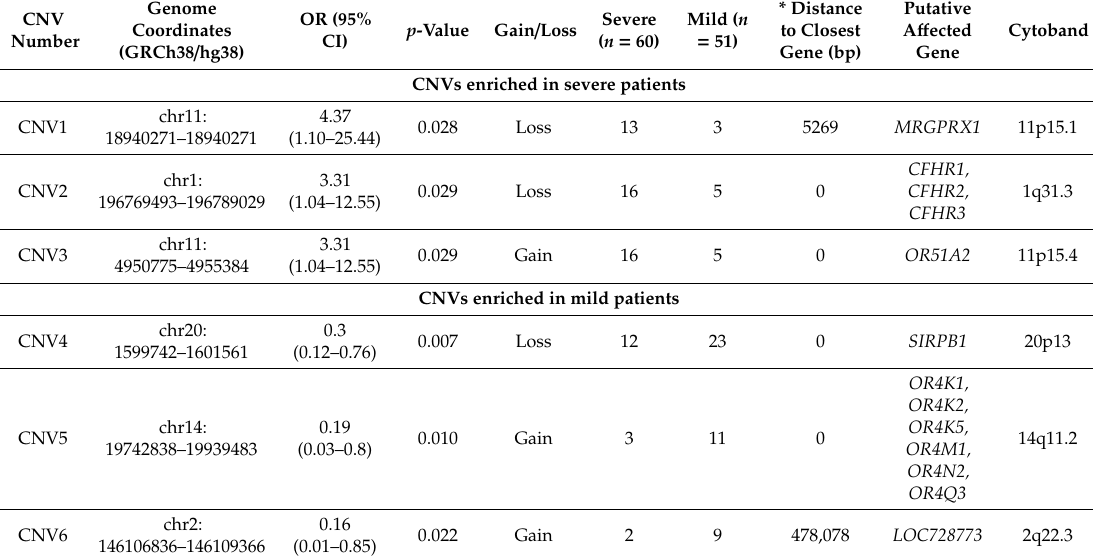
Table 2. CNV frequencies in HCPS mild and severe